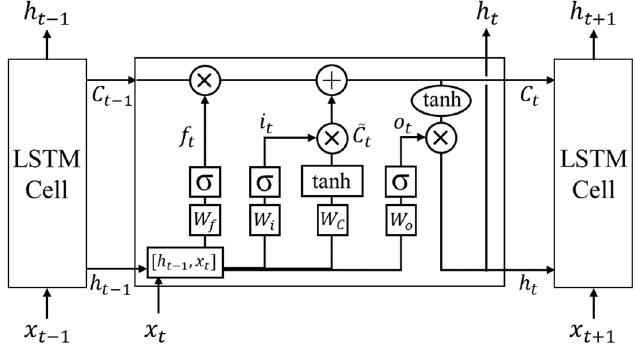
Figure 5. LSTM structure.